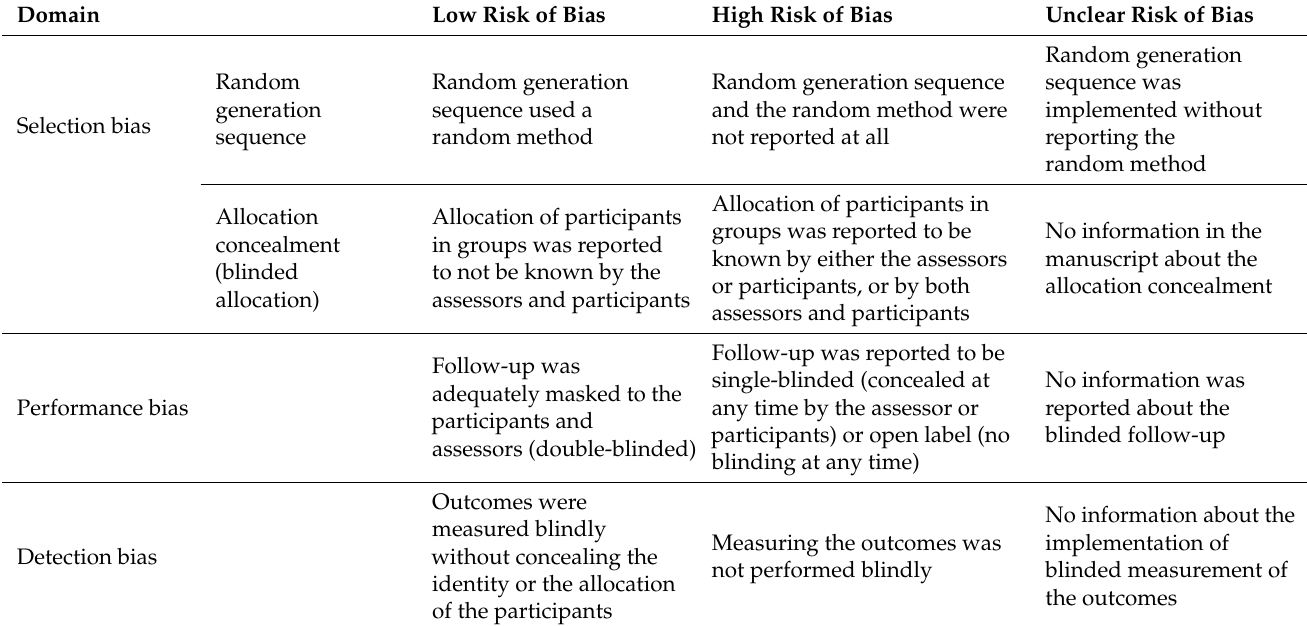
Table 1. Domains of the RoB 2 tool for the assessment of the risk of bias in randomized controlled